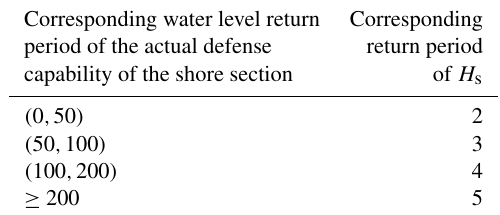
Table 3. H s value corresponding to return period (unit: a).